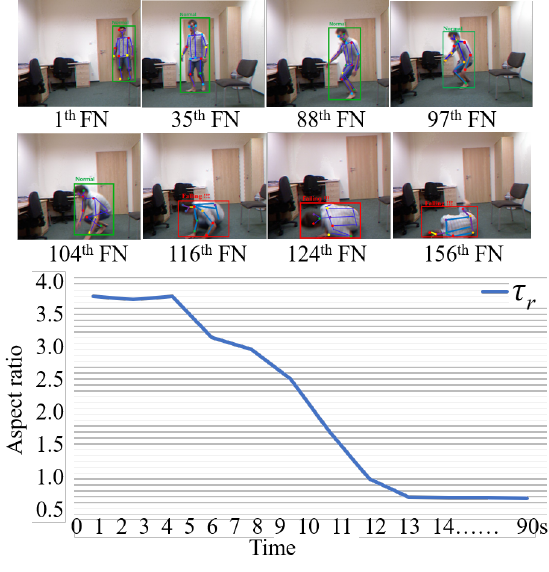
Fig. 4. Selection process of human body calibration frame aspect ratio threshold.